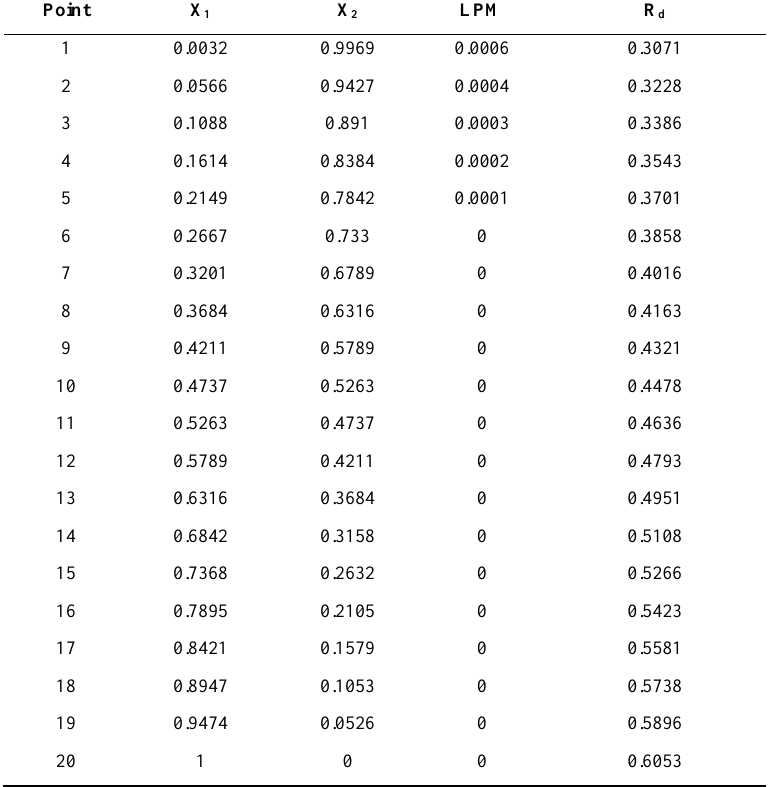
Table2. Portfolio forming efficient frontier with LPM and Rnec=